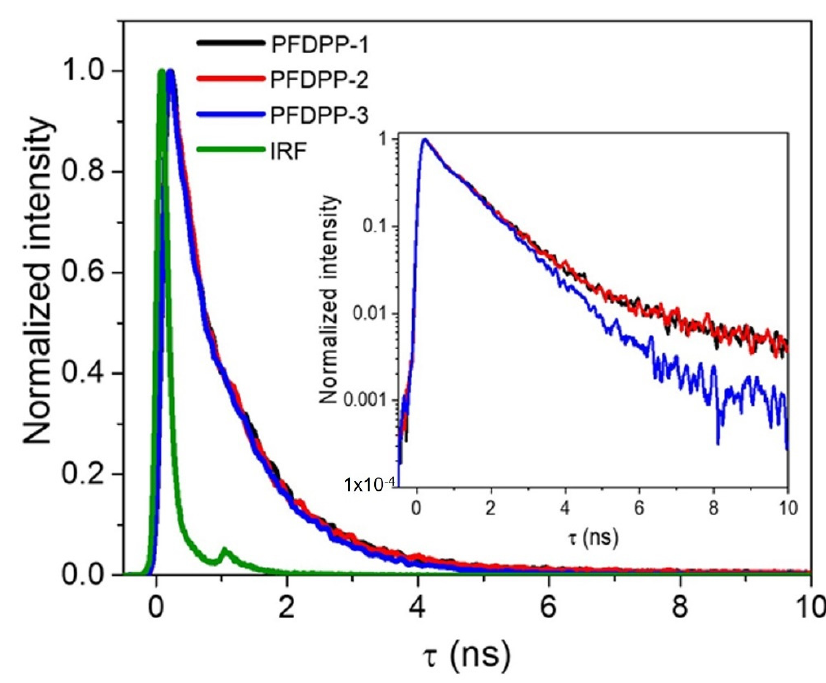
Figure 6. Lifetime fluorescence of the PFDPP polymers at 700 nm. ( λ ex = 404